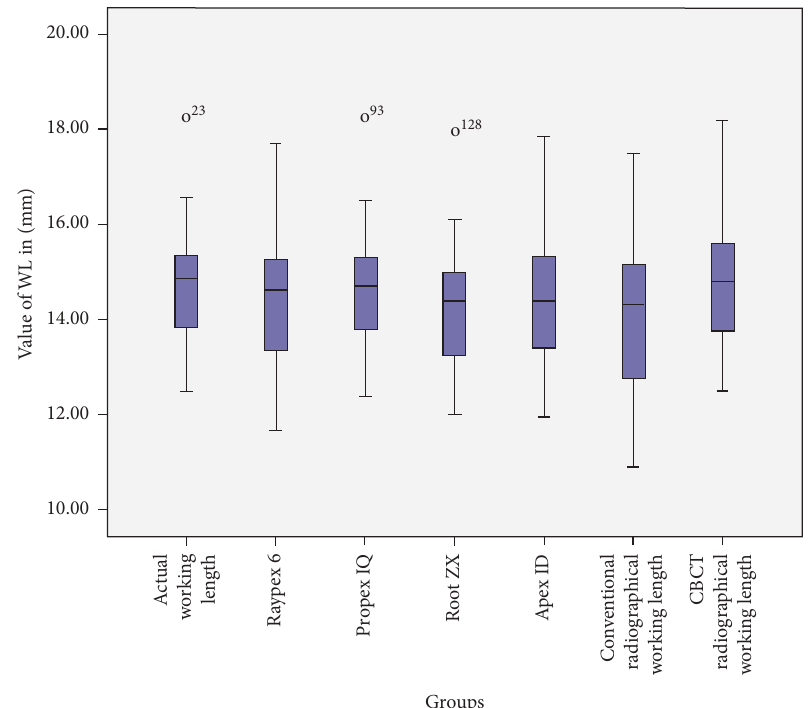
Figure 3: Boxplot showing the mean WL values in mm for four different electronic apex locaters and conventional periapical radiographs and CBCT scans in comparison with the actual WL values. Table 2: Mean WL values in mm obtained for each group in comparison with the actual WL (control group) values. Groups